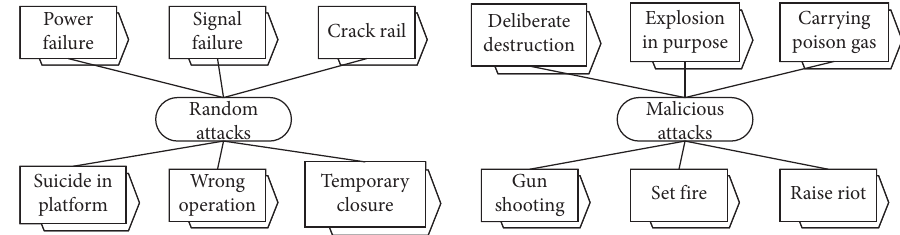
Figure 1: Examples of attack